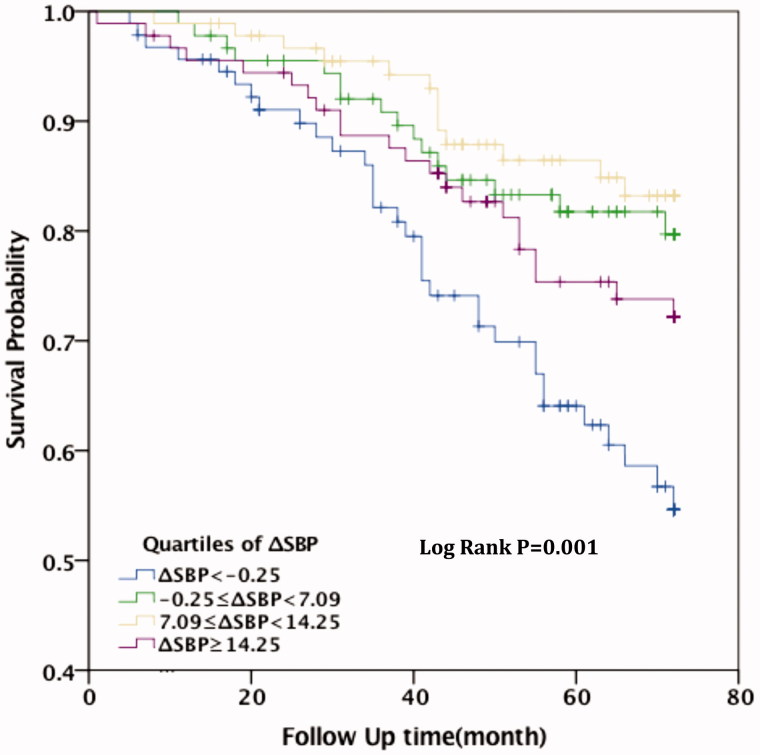
Kaplan–Meier shows the relationship between ΔSBP and cardiovascular disease mortality.